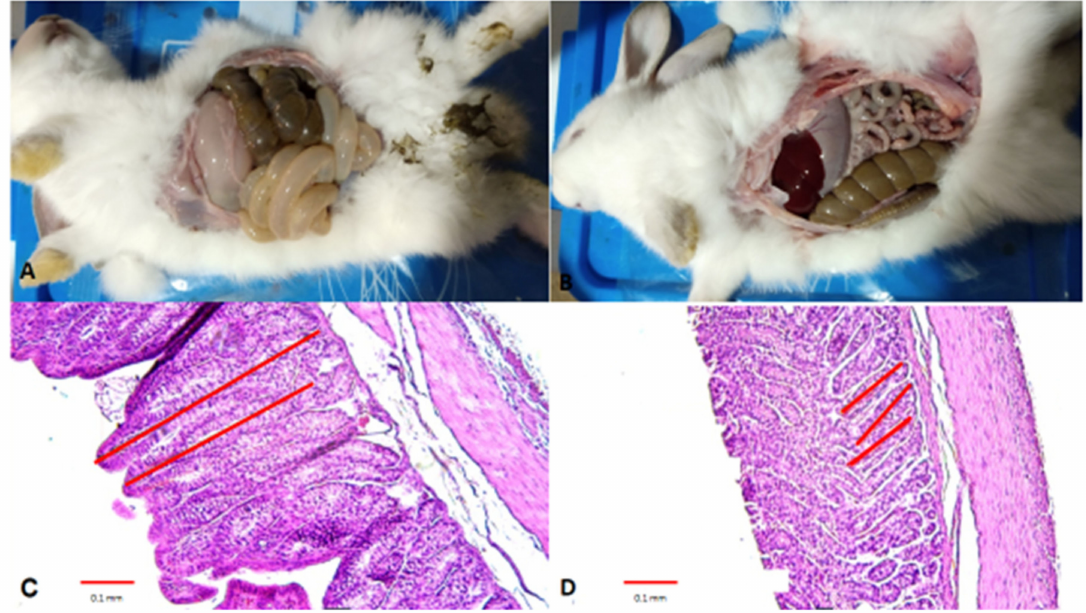
Figure 1. Histopathological study of rabbit digestive tracts. ( A ) Image of necropsy of a healthy rabbit; ( B ) Image of necropsy of an Epizootic rabbit enteropathy (ERE)-infected rabbit; ( C ) Section of villi of the colon of a healthy rabbit; ( D ) Section of villi from an ERE-infected rabbit colon. For ( C , D ), the red lines show the length of the crypts.